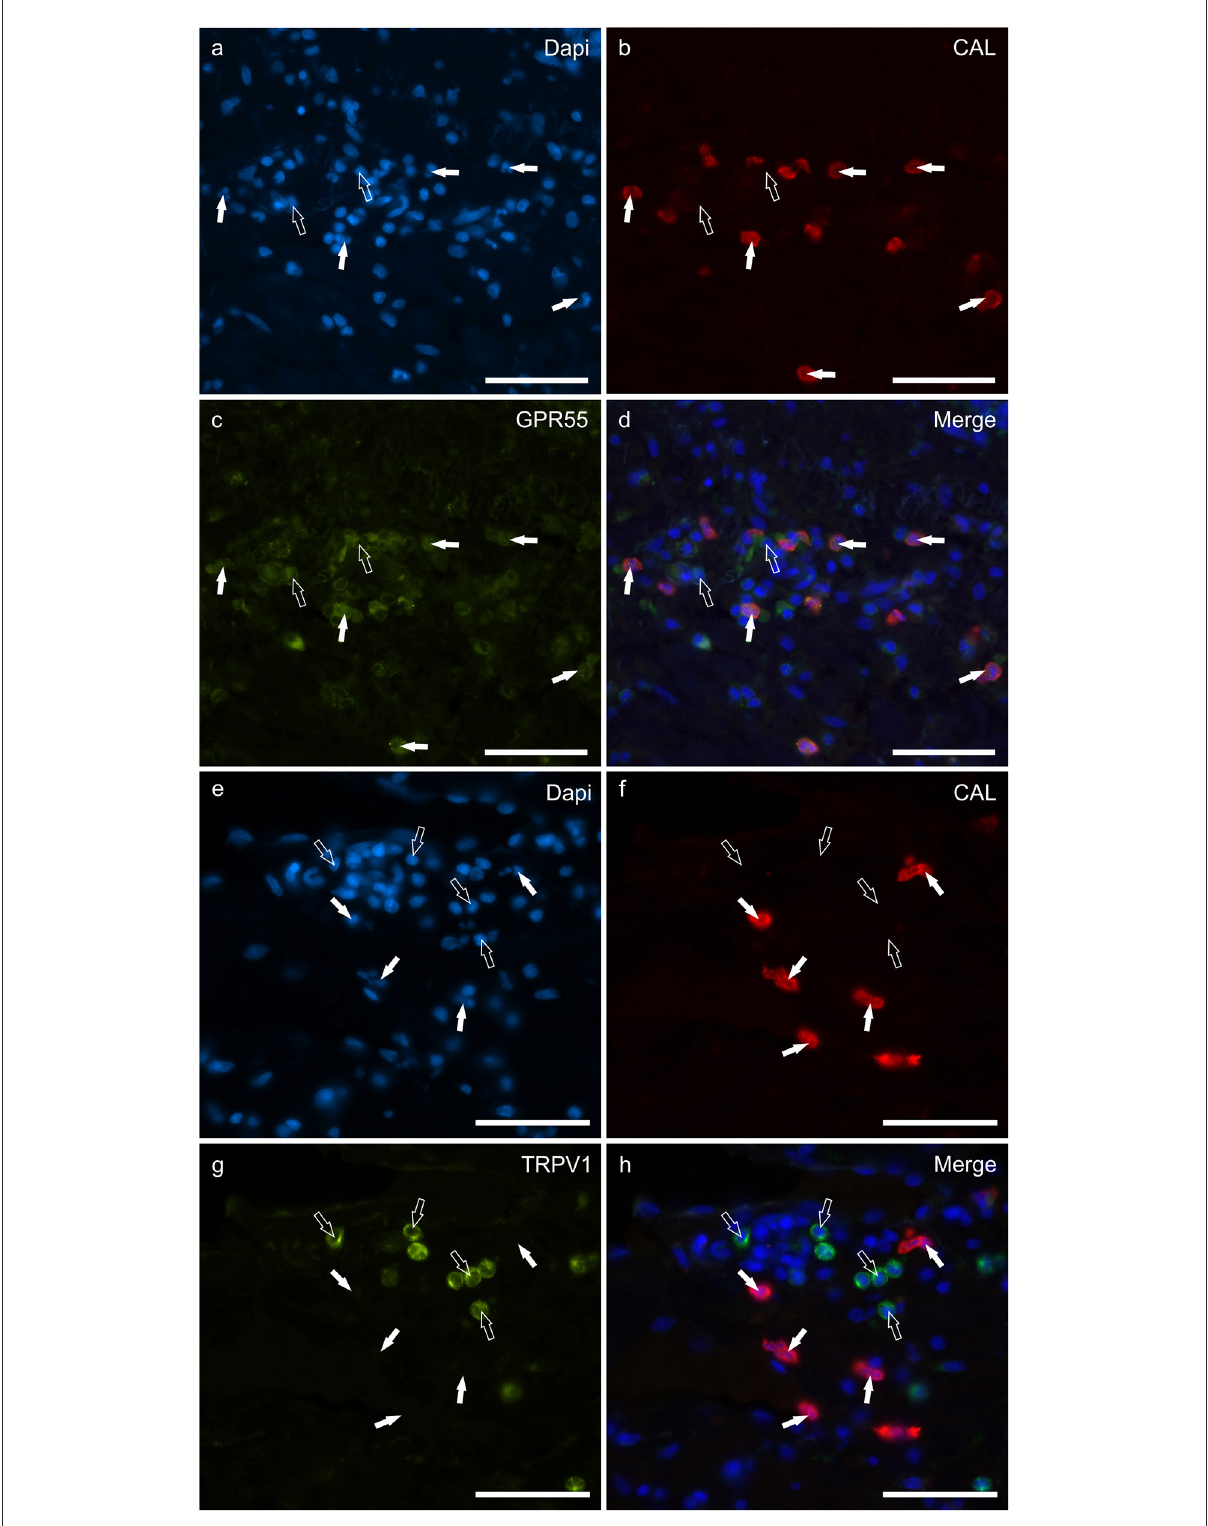
FIGURE5 Photomicrographs of the cryosections of the skin of dogs with atopic dermatitis (AD) showing Calprotectin (CAL) immunoreactive cells expressing G-protein coupled receptor 55 (GPR55) (a–d) and transient receptor potential vanilloid 1 (TRPV1) immunoreactivity (IR) (e–h) . (a–d) The white arrows indicate the Dapi-labeled nuclei of CAL positive cells co-expressing GPR55-IR (c) . The open arrows indicate some CAL negative cells expressing GPR55-IR (c) . (e–h) The white arrows indicate the Dapi-labeled nuclei of the CAL positive cells which were TRPV1 negative (g) . The open arrows indicate some TRPV1-IR cells which were CAL negative (g) . Bar: 50 µ